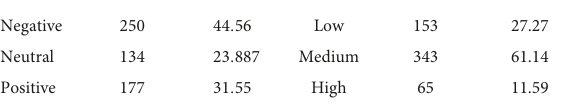
TABLE 1 Emotional dimensions for 561 phone call